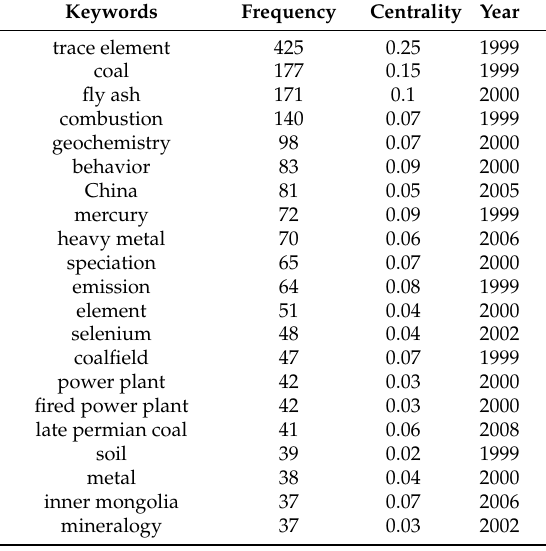
Figure 9. The TimeZone of keywords of trace elements in coal and ash. Table 5. Characteristics by year of high frequency keywords of trace elements in coal and ash.